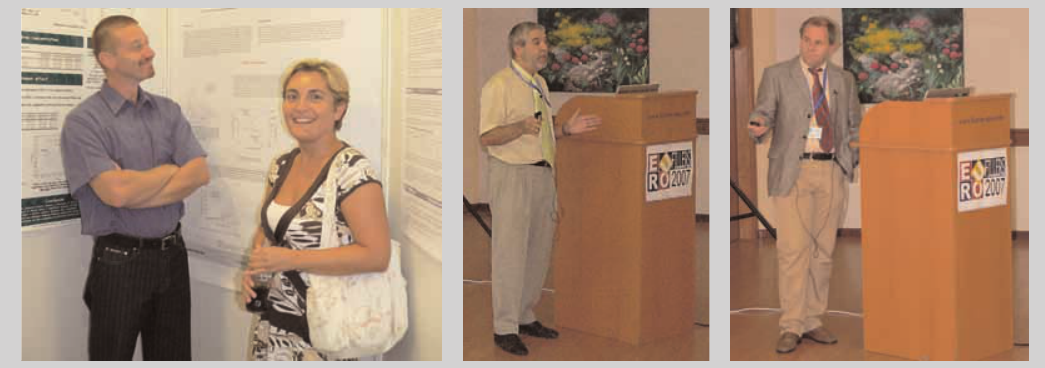
Left: Participants at the poster session in front of contributions from Hun- gary, India, and France. Middle: J. M. Martin-Mar- tinez during his talk about nanosilcate fillers. Right: Markus Gahleitner discusses the morphology, rheological properties and impact strength of ternary